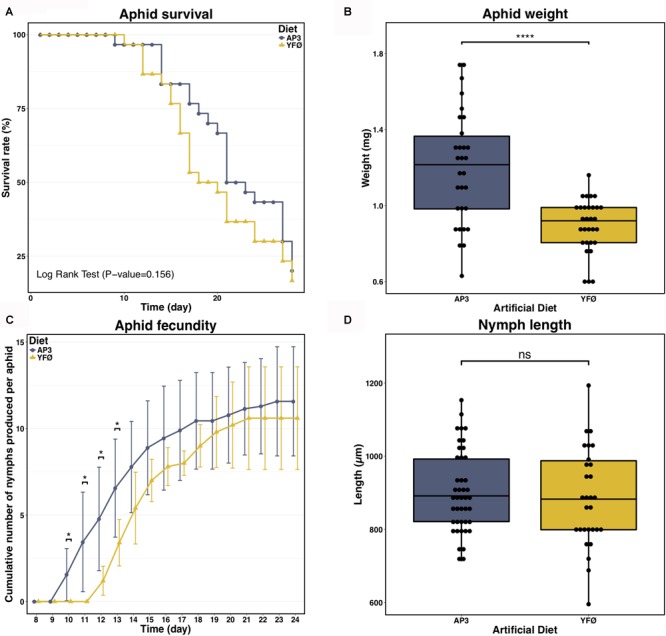
Impact of the tyrosine and phenylalanine depleted diet on aphid performances. (A) Survival analysis of A. pisum reared on two artificial diets: a complete diet (AP3, blue) and a Tyr/Phe depleted diet (YFØ, yellow). Each diet group was composed of 30 aphids. Data were analyzed using Log Rank Test. (B) Effects of the YFØ diet on aphid weight 7 days after the transfer on artificial diets. Each diet group was composed of 30 aphids. Data were analyzed using Welch’s t-test and significant differences are indicated with asterisks (∗∗∗∗P ≤ 0.0001). (C) Cumulative number of progeny laid per aphid reared on the YFØ and AP3 diets. Results are reported as means (±SD) of 10 isolated individuals per diet. Data were analyzed by a Welch’s t-test and significant differences are indicated with asterisks (∗P ≤ 0.05). (D) Effects of the YFØ diet on the size of produced nymphs. A total of 43 and 29 nymphs were measured for the AP3 and YFØ diet, respectively. Data were analyzed using Student’s t-test (ns, not significant).